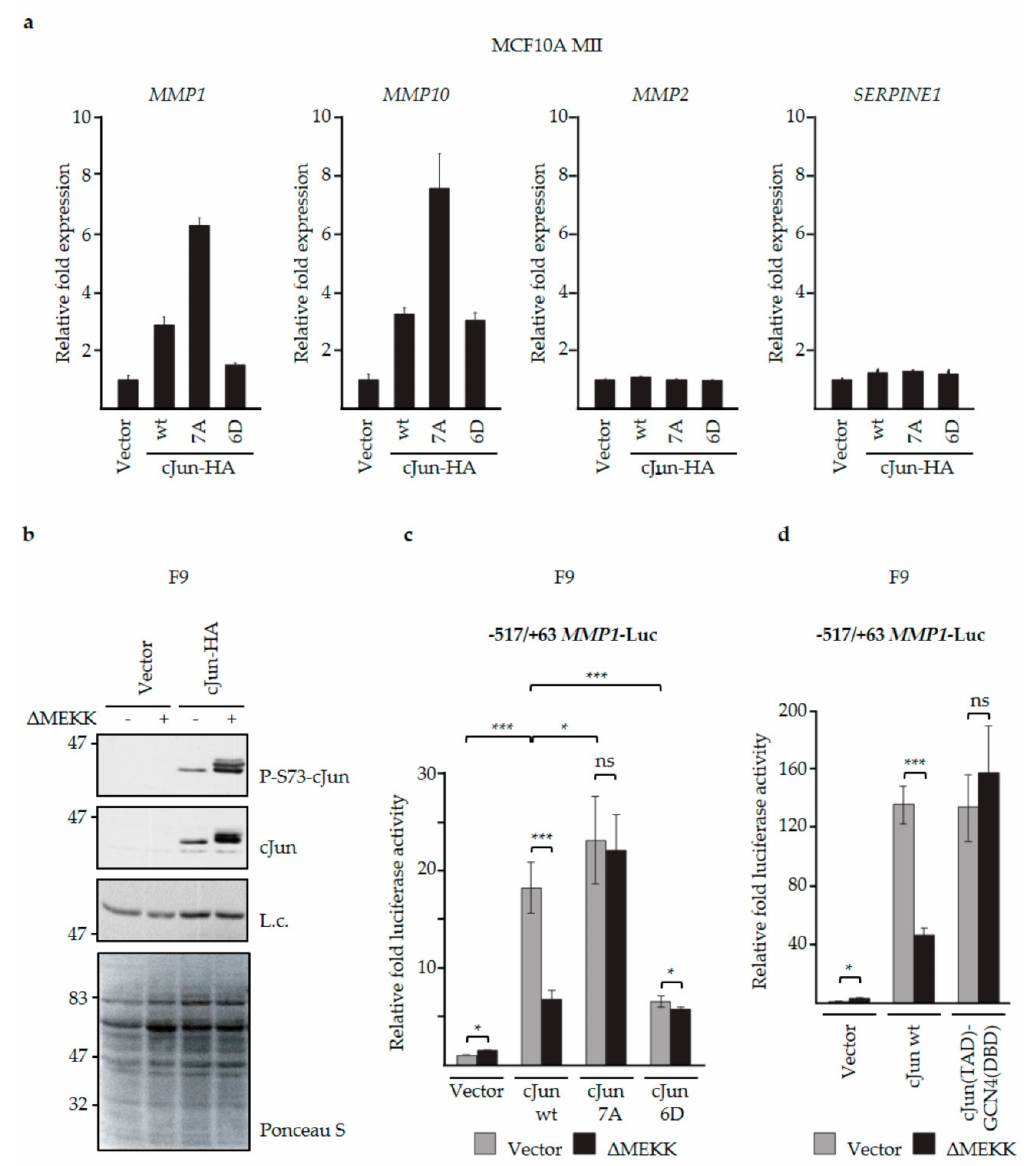
Figure 4. N-terminal cJun phosphorylation negatively a ff ected the activation of MMP1 and MMP10 . ( a ) MCF10A MII cells were transfected with expression vectors for wt cJun as well as cJun-6D and -7A mutants, and MMP1, MMP10, MMP2, and SERPINE1 mRNA levels were analyzed by qPCR and normalized to GAPDH , which was not significantly a ff ected by the treatments; ( b ) F9 cells were transfected with expression vectors for constitutively active ∆ MEKK and cJun-HA as indicated. After 6 h, cell extracts were prepared for immunoblotting analysis with antibodies specific for phosphorylated cJun-Ser73 or total cJun. A background band of the cJun blot (L.c.) and Ponceau S staining were included as loading control; ( c ) F9 cells were transfected with the -517 /+ 63 pGL3 MMP1 luciferase reporter and expression vectors for constitutively active ∆ MEKK and wt cJun, and cJun-6D or -7A mutants, as indicated. After 6 h, cell extracts were prepared and luciferase activity was analyzed; * p < 0.05, *** p < 0.001. ( d ) F9 cells were transfected with the -517 /+ 63 pGL3 MMP1 luciferase reporter and expression vectors for constitutively active ∆ MEKK and cJun wt or cJun-GCN4—a chimeric protein in which the DNA-binding domain (DBD) of cJun is replaced by the corresponding DNA-binding domain of GCN4, as indicated (TAD: transactivation domain). After 16 h, cell extracts were prepared and luciferase activity was